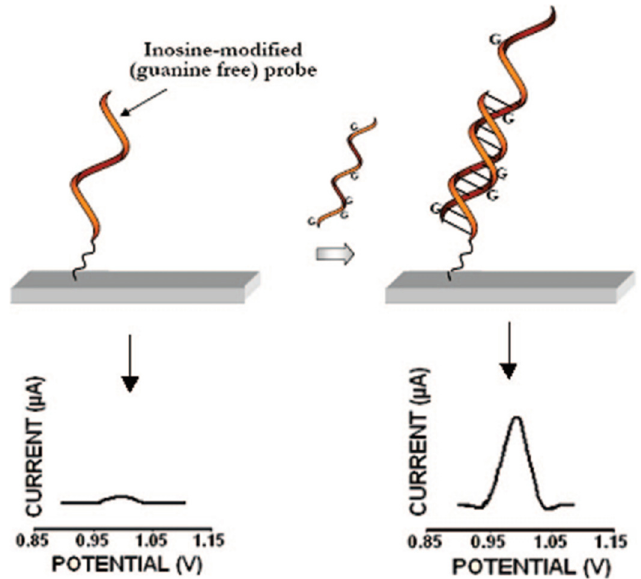
Figure 4. Illustration of label-free electrochemical biosensor based on guanine oxidation [124], reprinted with permission from American Chemical Society.